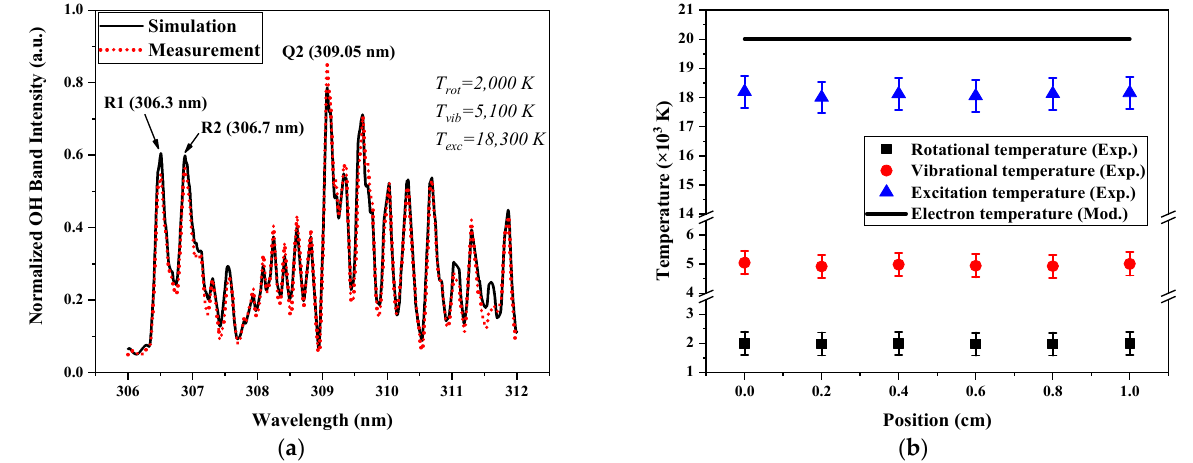
Figure 7. ( a ) Experimental emission spectrum of the OH A 2 Σ → X 2 Π band (dots) with their SPECAIR fitting (line) for the determination of the rotational, vibrational, and excitation temperatures. ( b ) Variations of rotational, vibrational, and excitation temperatures as a function of position at the AC voltage of 22 kV and 1 cm distance between electrodes.